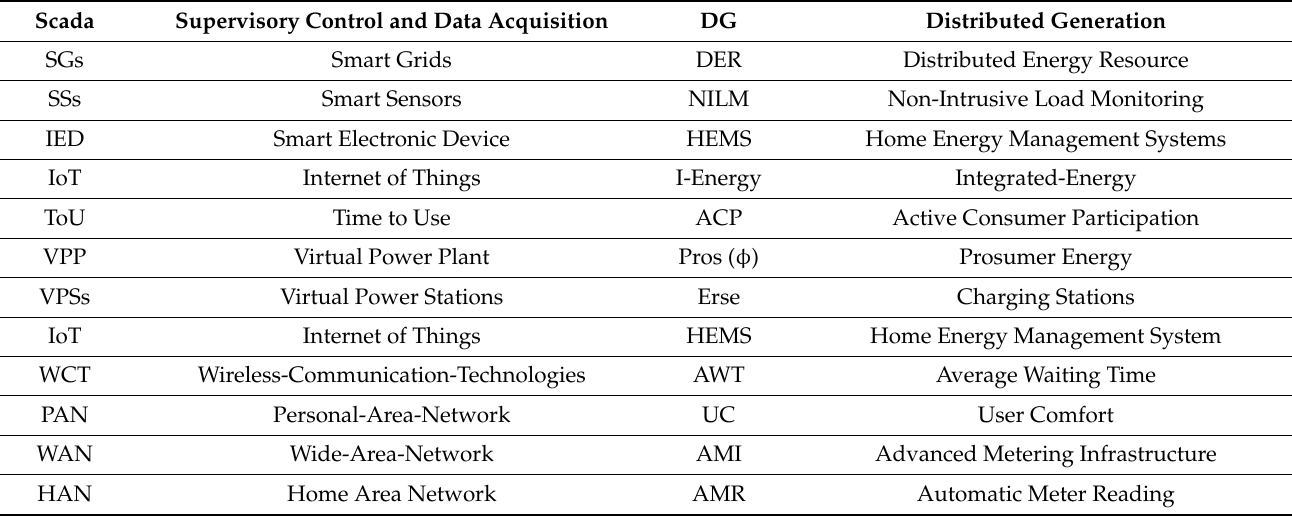
Table 1. List of